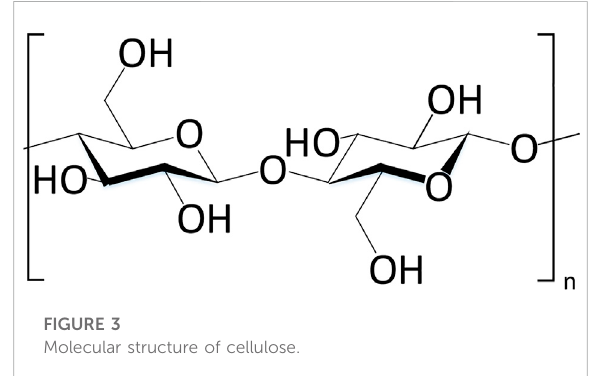
FIGURE 3 Molecular structure of